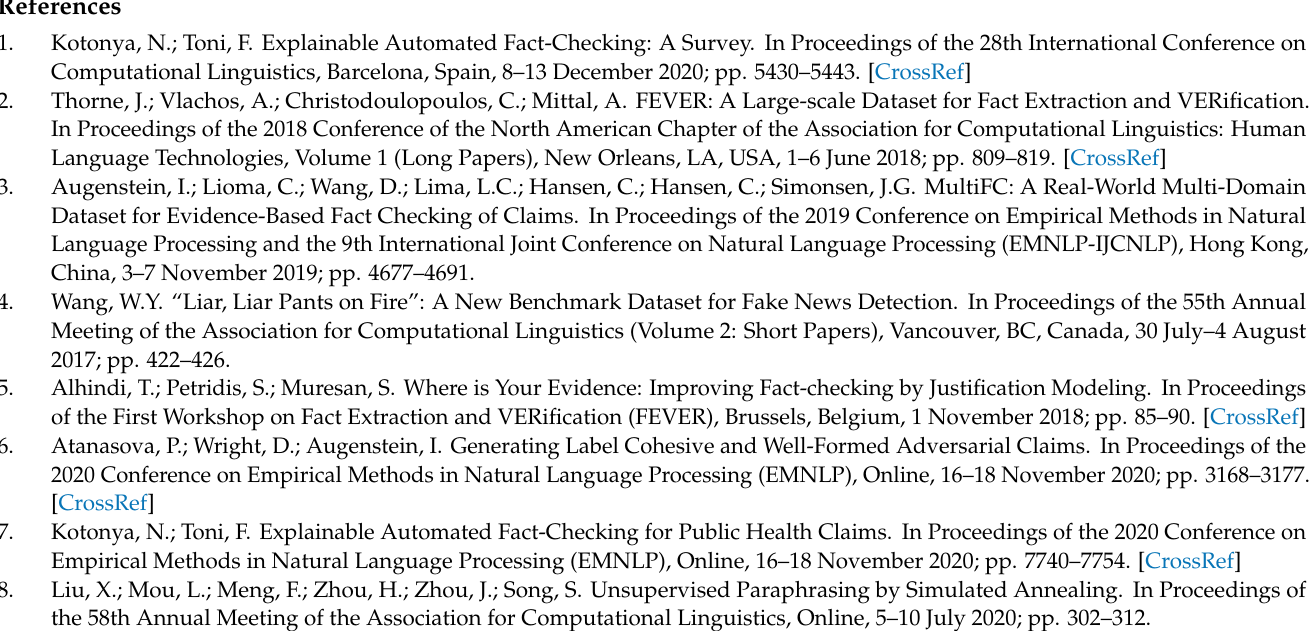
These experiments were run on a single NVIDIA TitanRTX GPU with 24 GB memory and 4 Intel Xeon Silver 4110 CPUs. Model training took ∼ 3